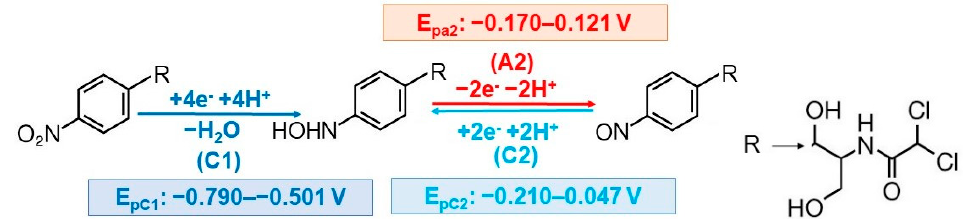
Figure 3. Schematic representation of CAP general electroreduction mechanism.